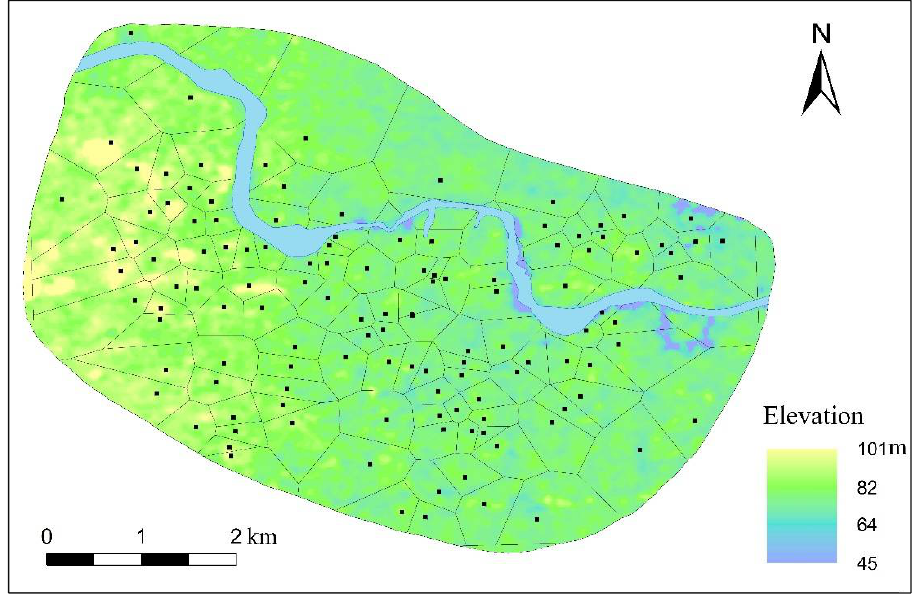
Figure 3. Thiessen’s polygon division based on dwellings at Yinxu.